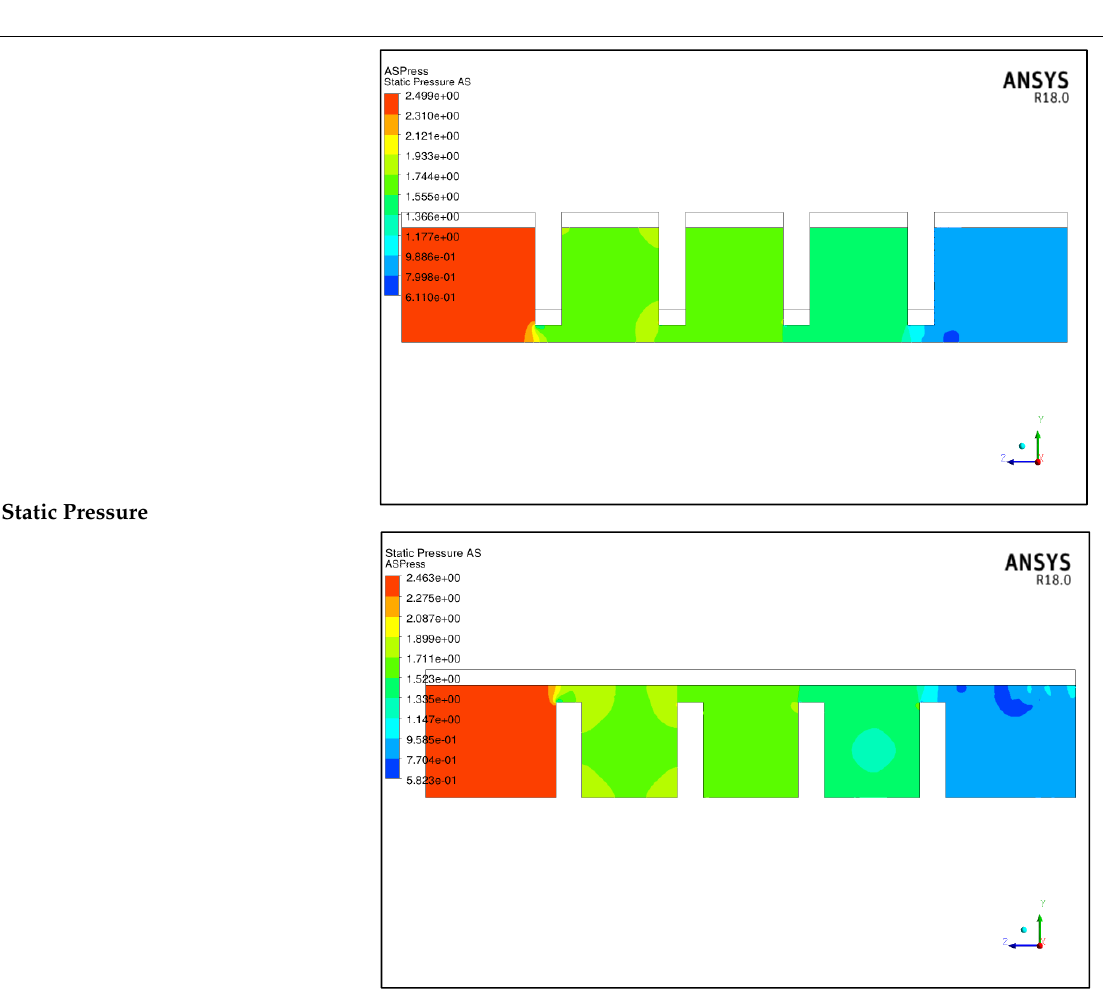
Table A2. Static pressure fields.